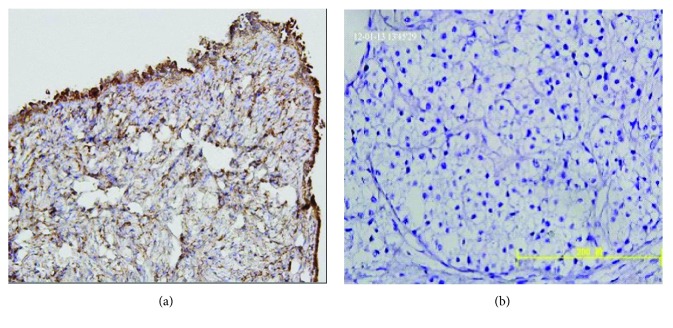
Expression of Wnt5a in normal ovarian tissue and ovarian cancer. Normal ovaries with immunostaining of Wnt5a in the cytoplasm of tumor cells. Staining index (SI = 7) in epithelial ovarian tissues. Immunolabeling in the cytoplasm of fibroblasts on the (a) (40x). Ovarian cancer was clear-cell cancer, in the cytoplasm of tumor cells (40x; SI = 0).